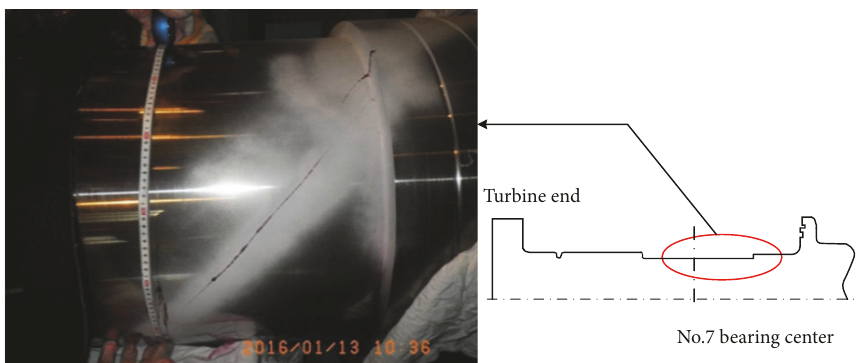
Figure 2: An example of cracks on No. 7 journal of Unit-1